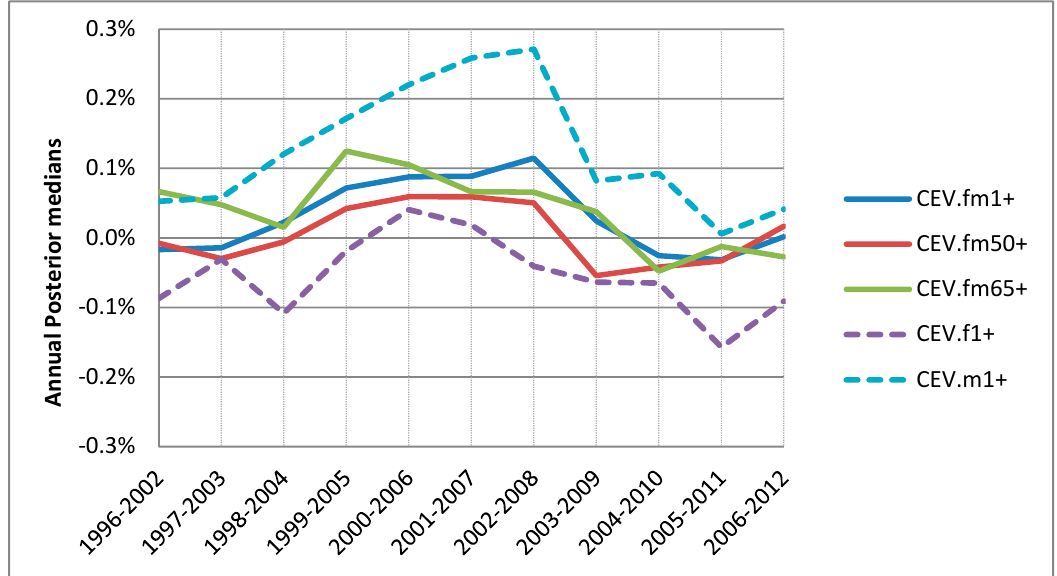
Figure 8. Annual associations between warm season 1-day lagged ozone and CEV hospitalizations for 5 groups: base group (fm1+) in solid blue; over50 group, (fm50+) in solid red; seniors (fm65+) in solid green; females aged ≥ 1 (f1+) in dashed purple; and males aged ≥ 1 (m1+) in dashed blue.